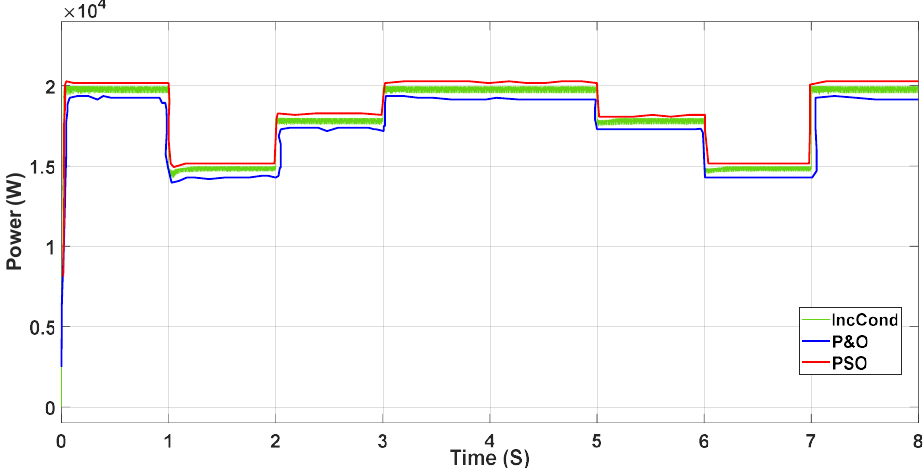
Figure 28. PSO, P&O, and IncCond MPPT comparison under different irradiance values.